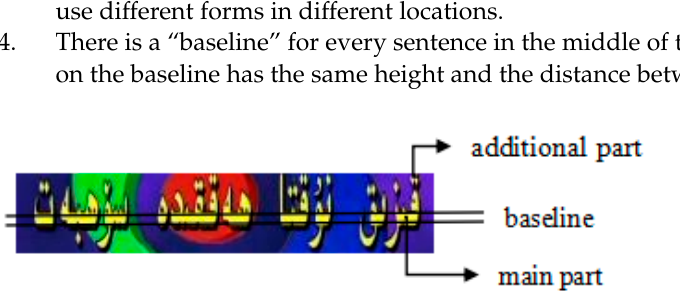
Figure 1. The characteristics of Uyghur text.